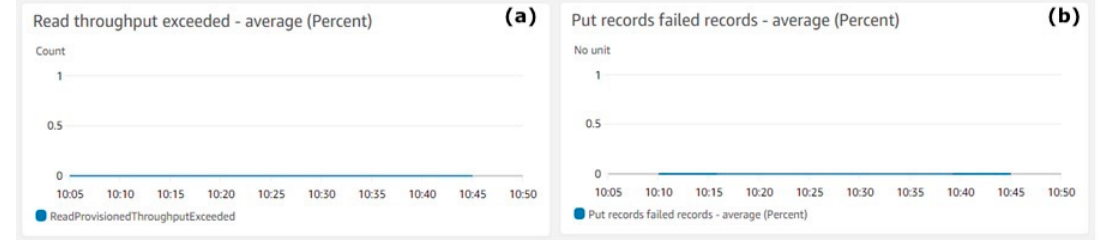
Figure 5. Kinesis Data Stream errors. ( a ) Read throughput exceeded—average, ( b ) Put records failed records—average (percent).